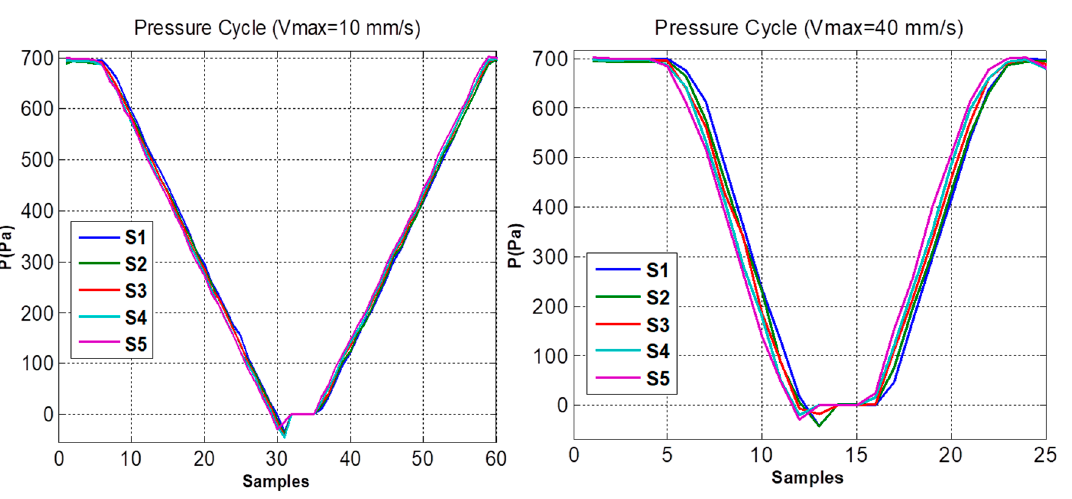
Figure 11. Pressure measurement performed during a cycle when the velocity is 10 and 40 mm/s.